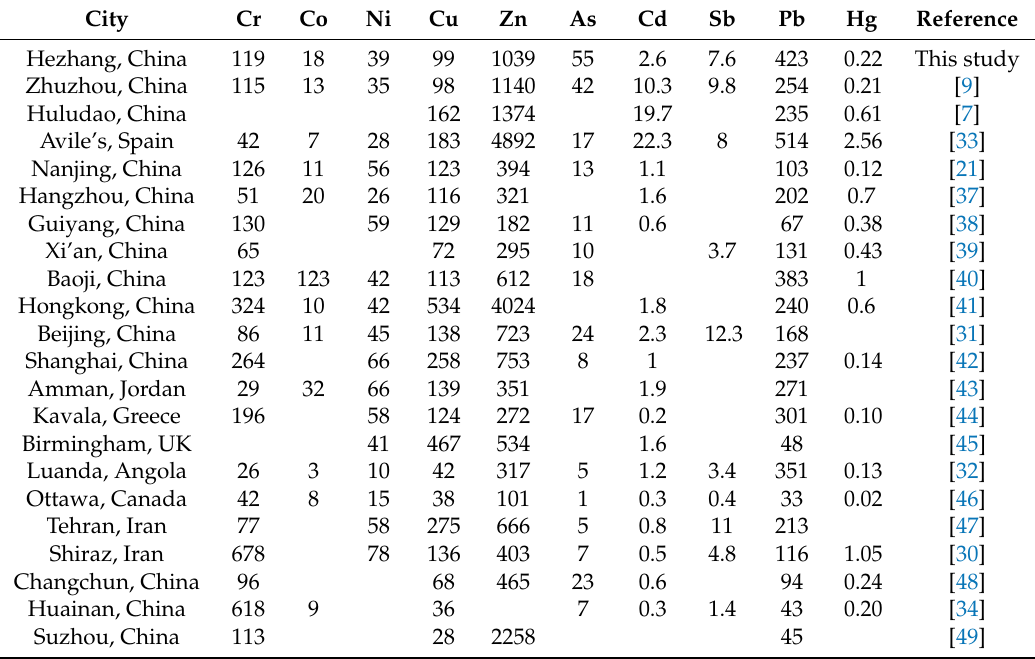
Table 4. Comparison of trace metal(loid)s in street dust of different cities in the world (unit in mg kg − 1 , dry